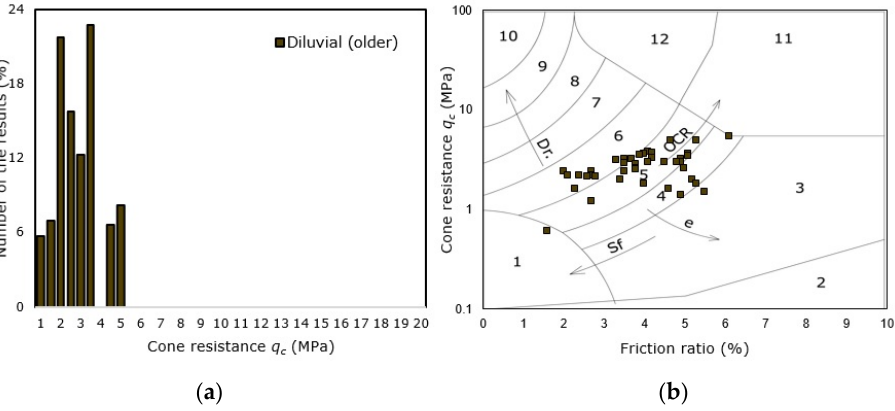
Figure 6. Summary of results for the older diluvial facies: ( a ) distribution of q c values and ( b ) sounding parameters plotted against Robertson’s chart (1—sensitive fine grained; 2—organic material; 3—clay; 4—silty clay to clay; 5—clayey silt to silty clay; 6—sandy silt to clayey silt; 7—silty sand to sandy silt; 8—sand to silty sand; 9—sand; 10—gravely sand to sand; 11—very silty fine grained; 12—sand to clayey sand; D r —density ratio; OCR—overconsolidation ratio; Sf—sensitivity factor; e—void